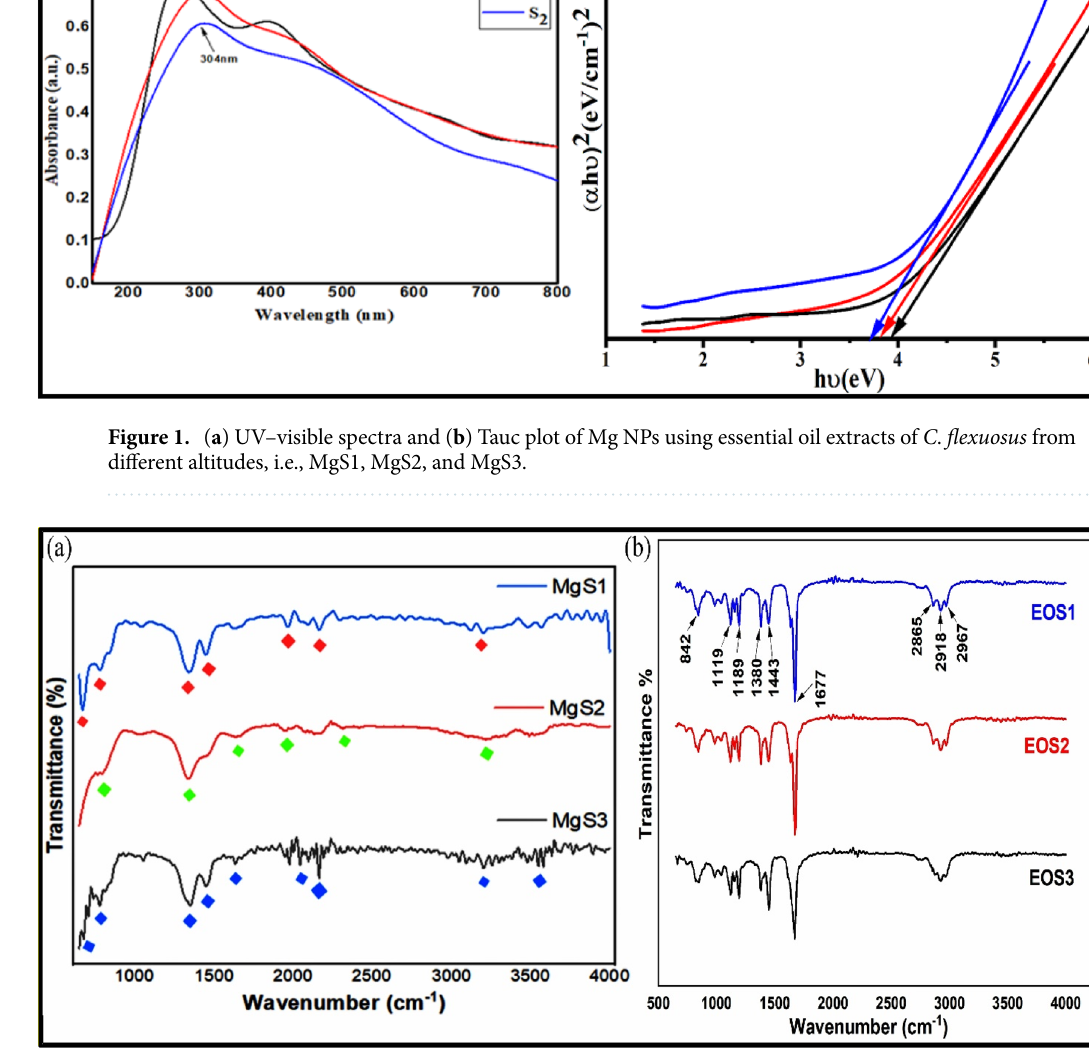
Figure 2. FTIR spectra for ( a ) MgNPs and ( b ) essential oil of C . flexuosus from different altitudes.